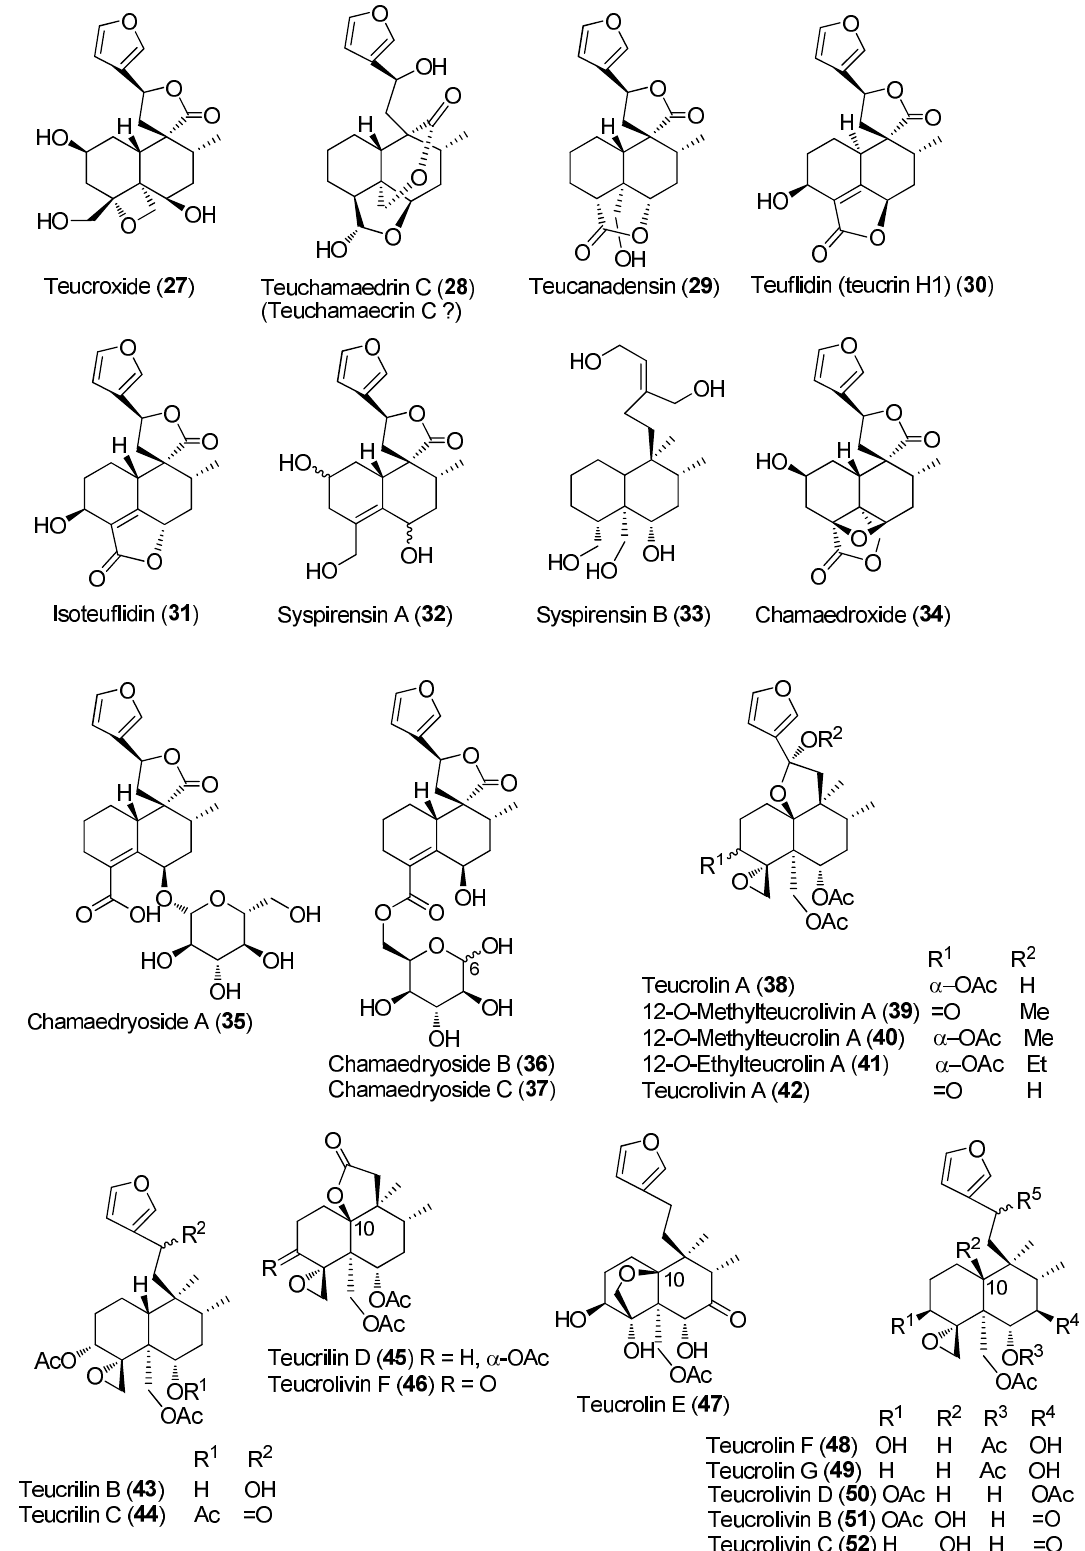
Figure 4. Representative neo -clerodane diterpenoids isolated from Teucrium chamaedrys and Teu- crium oliverianum .